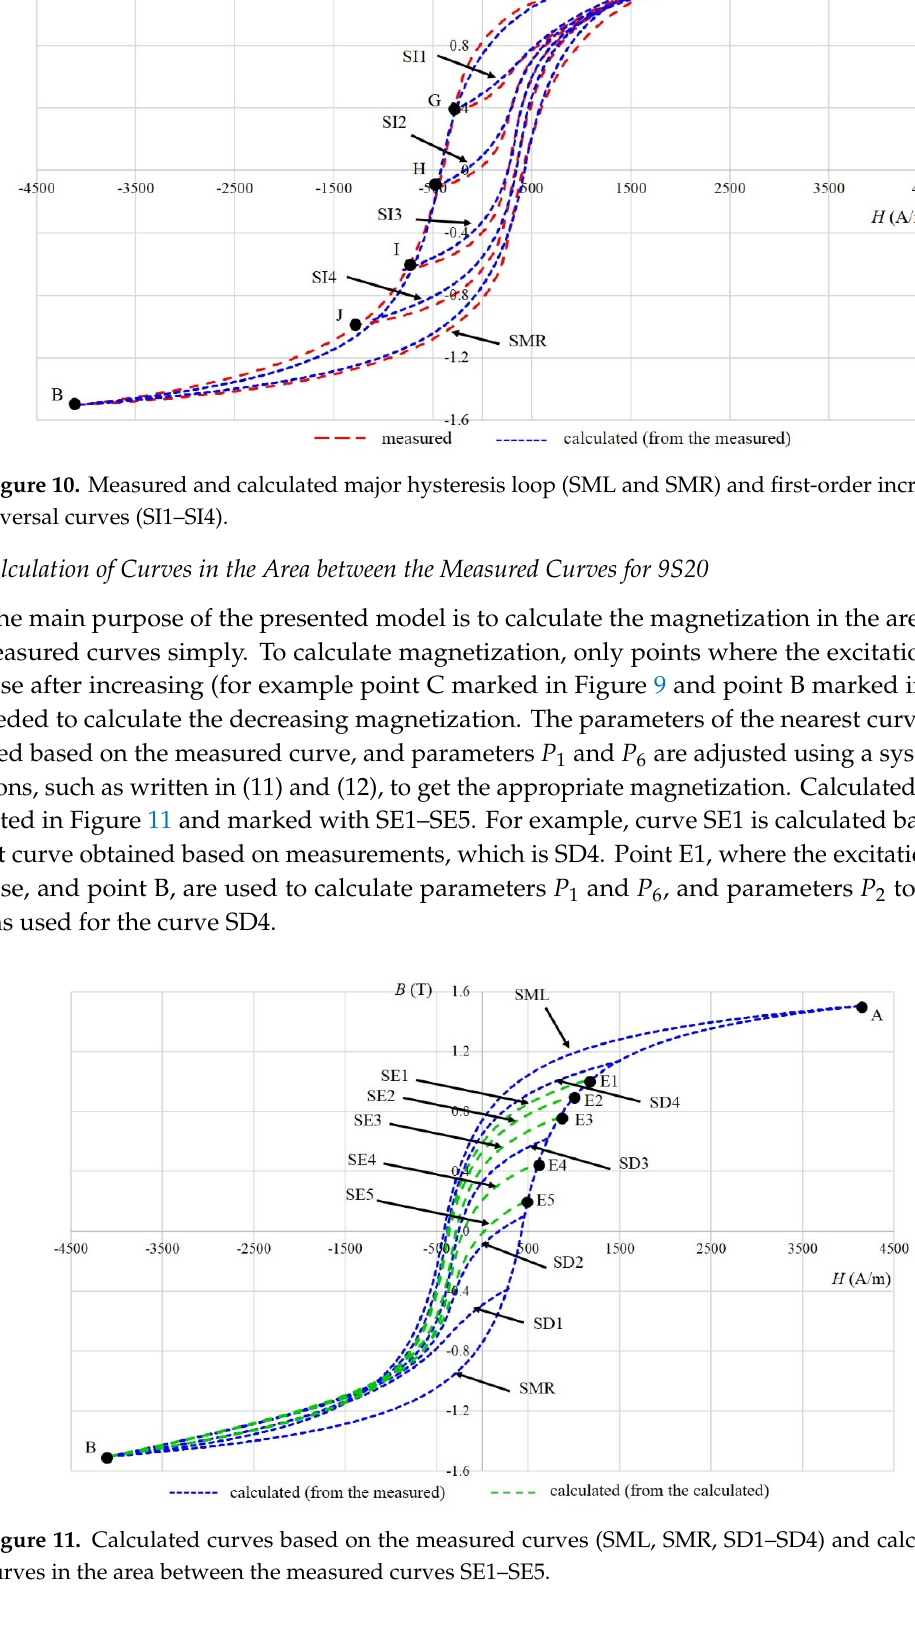
Table 16. Parameters of the calculated curves SE1–SE5. Basis curve, Points and Parameters